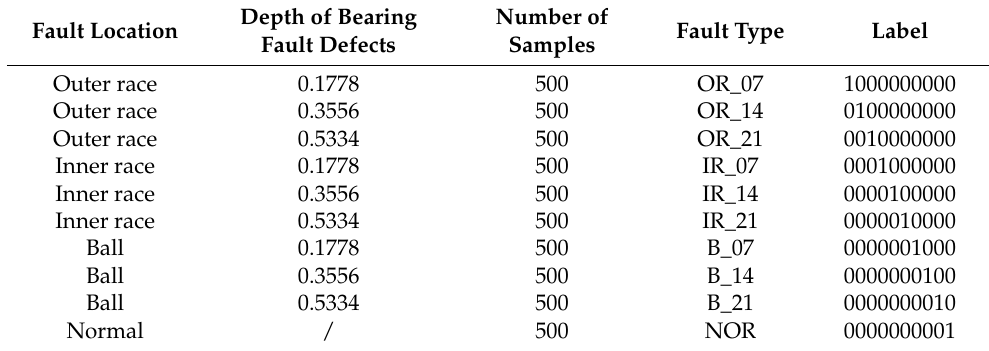
Table 1. Bearing status information (Western Reserve University).